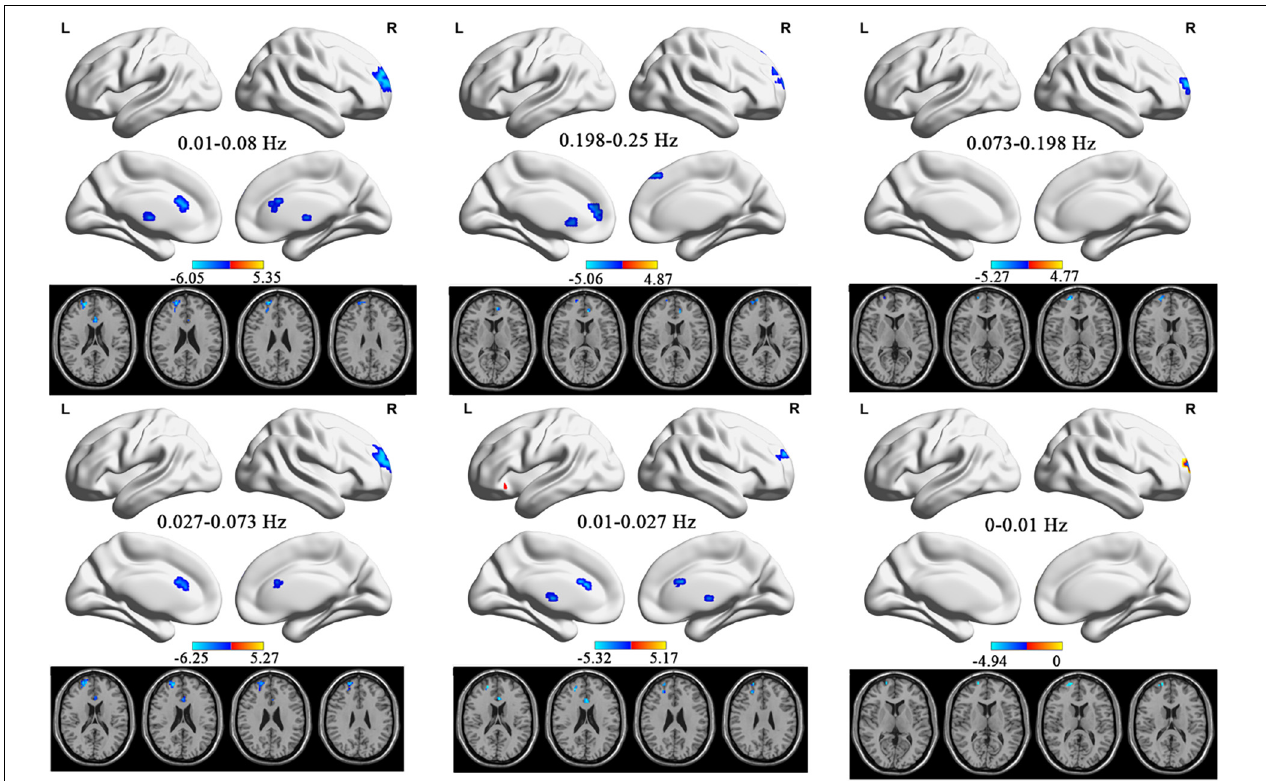
FIGURE 1 | The ALFF differences in the six frequency bands (conventional band, 0.01–0.08 Hz; slow-2, 0.198–0.25 Hz; slow-3, 0.073–0.198 Hz; slow-4, 0.027–0.073 Hz; slow-5: 0.01–0.027 Hz) between TTH patients and HCs. ALFF, amplitude of low-frequency fluctuation; TTH, tension-type headache; HC, healthy